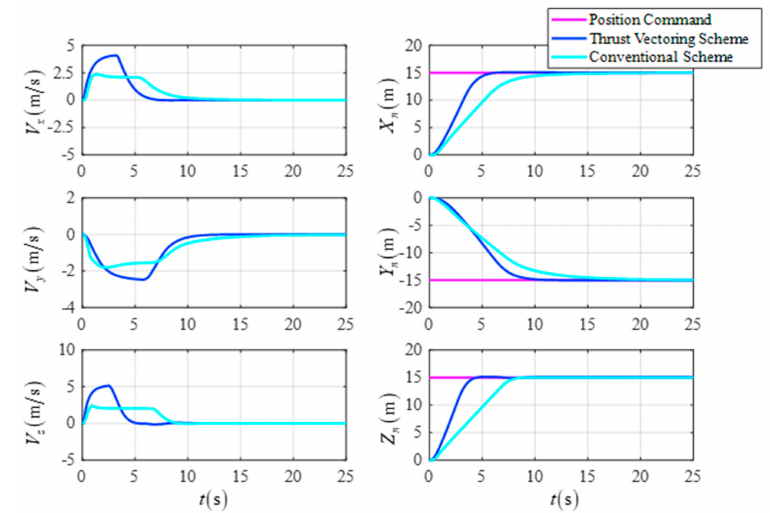
Figure 9. The position and the velocity in the target point flight.